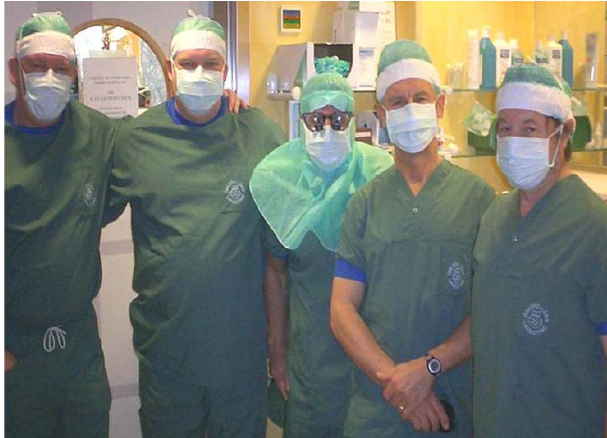
Fig. 1 - Preparing for a no-touch coronary artery bypass grafting operation in Örebro. A photograph taken on a trip to Örebro. Left to right: Mats Dreifaldt, David Abraham, Domingos Souza, Mick Dashwood, and Andrzej Loesch.